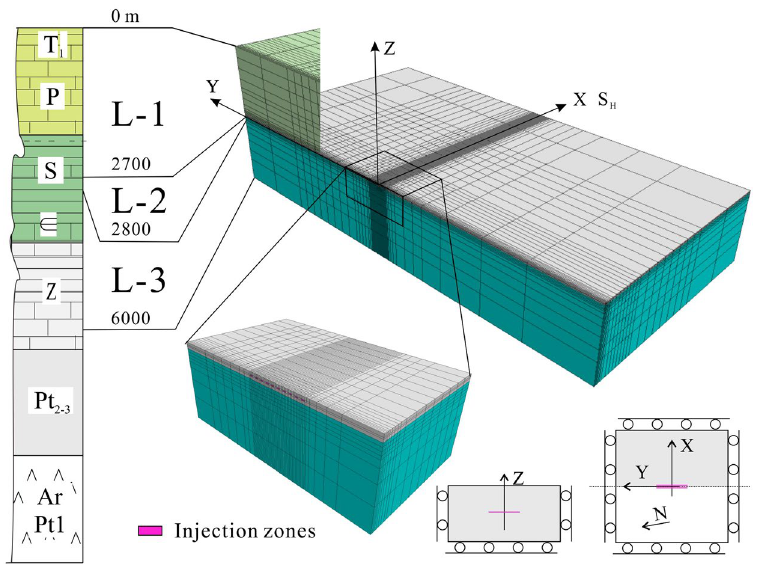
Figure 6. Numerical model for coupled thermal-hydrological-mechanical simulation of injections in horizontal wells for hydraulic